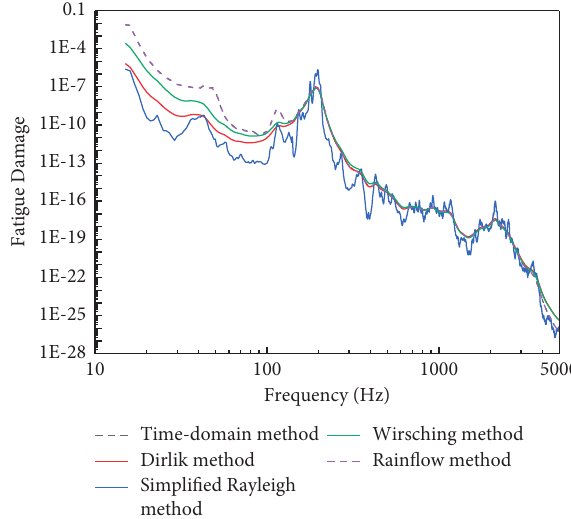
Figure 6: Comparison of FDS calculation results of different